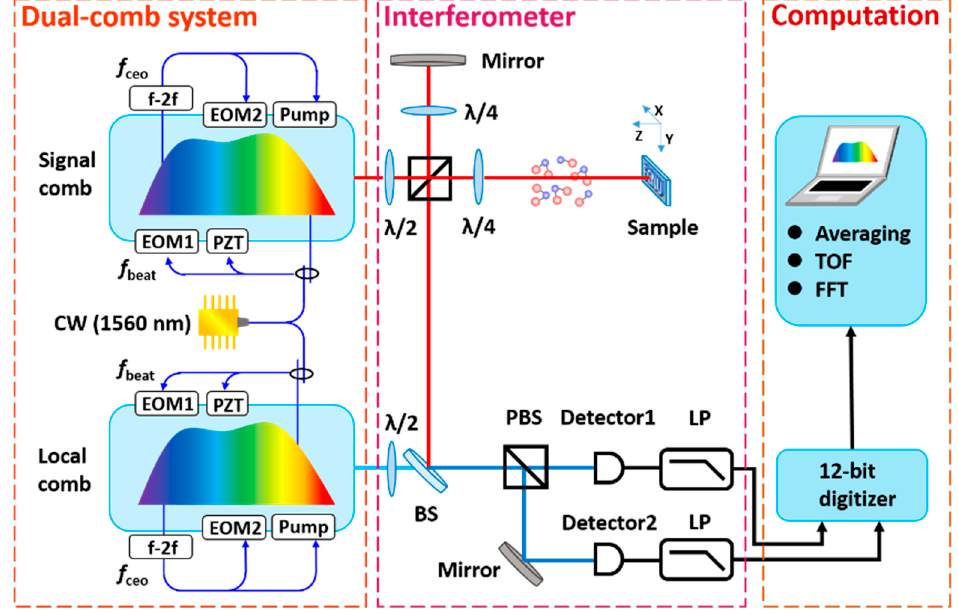
Figure 1. Configuration of the dual-comb interferometer to measure spectra and distance. EOM, electro-optic modulator; PZT: piezoelectric transducer; Pump: pump current; CW laser, narrow linewidth continuous-wave laser at 1560 nm; λ /2, the half-wave plate; λ /4, the quarter-wave plate; BS, the beam splitter; PBS, the polarization beam splitter; LP, the low-pass filter. To simultaneously analyze the spectrum and the absolute distance in a single measurement, the output of the signal comb was divided into two orthogonally polarized beams (the signal beam and the reference beam) by a half-wave plate (HWP) and a polarization beam splitter (PBS). The signal beam was used to detect the sample. This arm contained a gas cell and a designed “ECNU” logo in a silicon slice. The gas cell was filled with 60 kPa mixed gas (50% CO 2 , 50% CO) with a transmission path of ~8 m. The letter